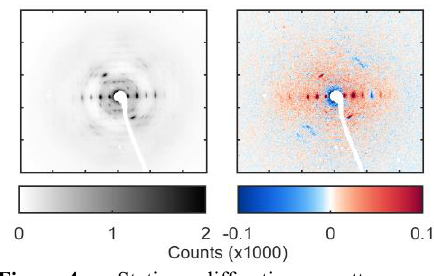
Fig. 2. DAS of global fit of TA data in the UV and visible on short and long time scales.